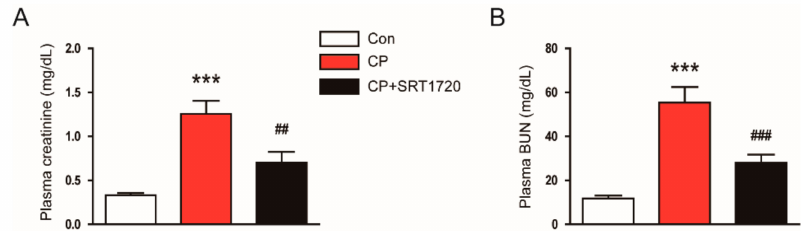
Figure 1. E ff ects of SRT1720 on renal function in mice treated with cisplatin. ( A ) Plasma creatinine. ( B ) Plasma blood urea nitrogen (BUN). *** p < 0.001 vs. control (Con). ## p < 0.01 and ### p < 0.001 vs. cisplatin alone (CP).